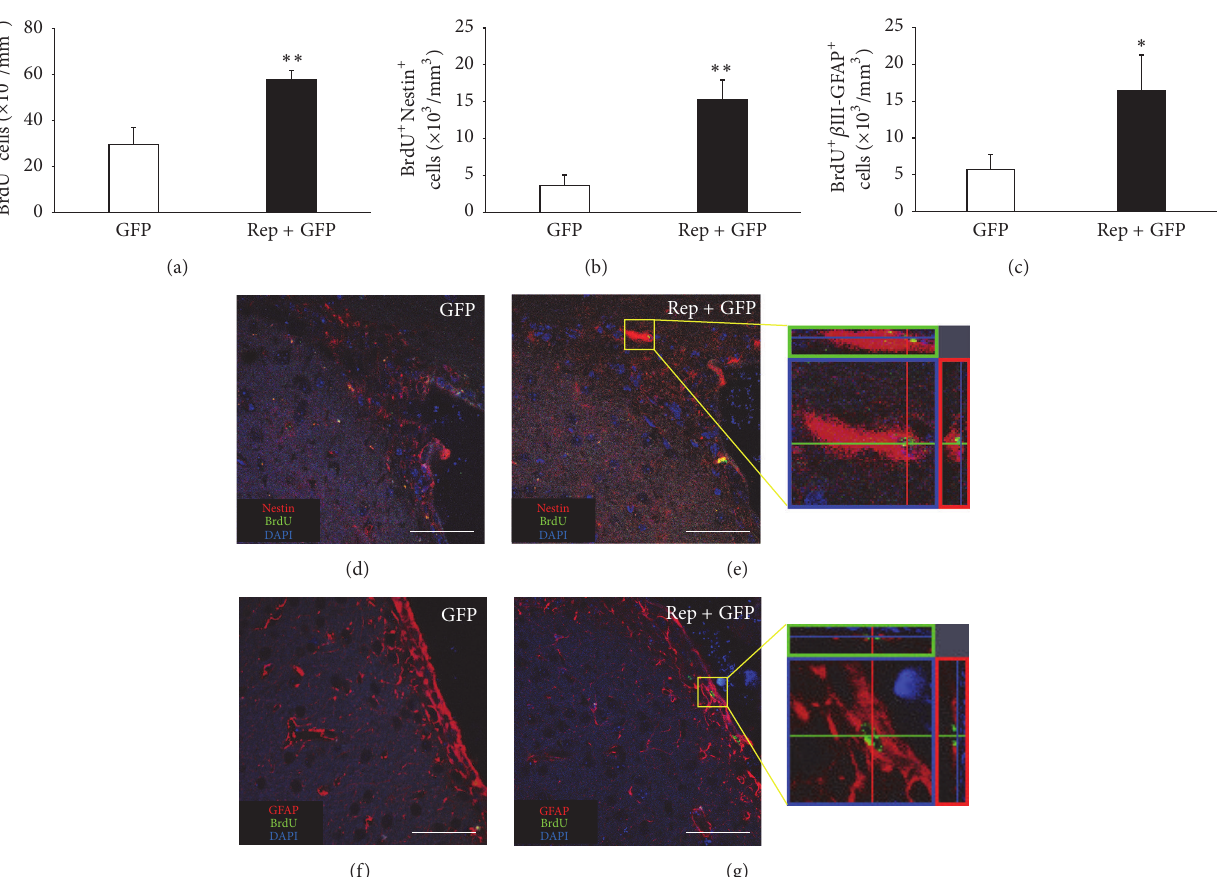
Figure 4: The number of neural progenitor cells in the subventricular zone increased by the in vivo expression of reprogramming factors. (a) The density of BrdU + cells in the subventricular zone was significantly higher in the treatment group than the control group ( 𝑡 = 3.596 , 𝑝 < 0.01 ). (b-c) The density of neural progenitor cells was determined through confocal microscopy by calculating the density of cells triple positive for DAPI (blue, nuclei), BrdU (green), and cell type-specific markers such as Nestin and GFAP. The densities of BrdU + Nestin + cells (b) and BrdU + GFAP + cells (c) were significantly higher in the treatment group than the control group ( 𝑡 = 3.868 , 𝑝 < 0.01 and 𝑡 = 2.631 , 𝑝 < 0.05 , resp.). (d–g) Confocal microscope images are immunohistochemistry results. (e, g) Cells with triple positive for DAPI, BrdU, and cell type-specific markers are indicated in the yellow box at the right panel. Scale bars = 50 𝜇 m. ∗ 𝑝 < 0.05 ; ∗∗ 𝑝 < 0.01